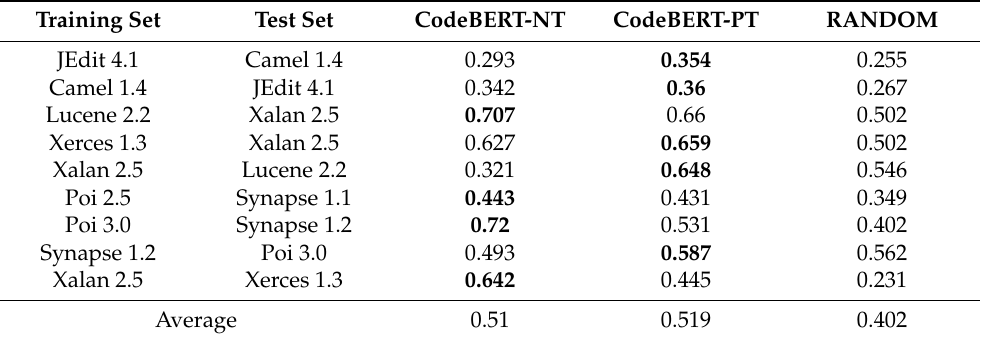
Table 4. Performance comparison of CodeBERT-NT, CodeBERT-PT, and RANDOM models on the CPPSC dataset for cross-project defect prediction. The float values are the average F-measure values. The best F-measure values are highlighted in